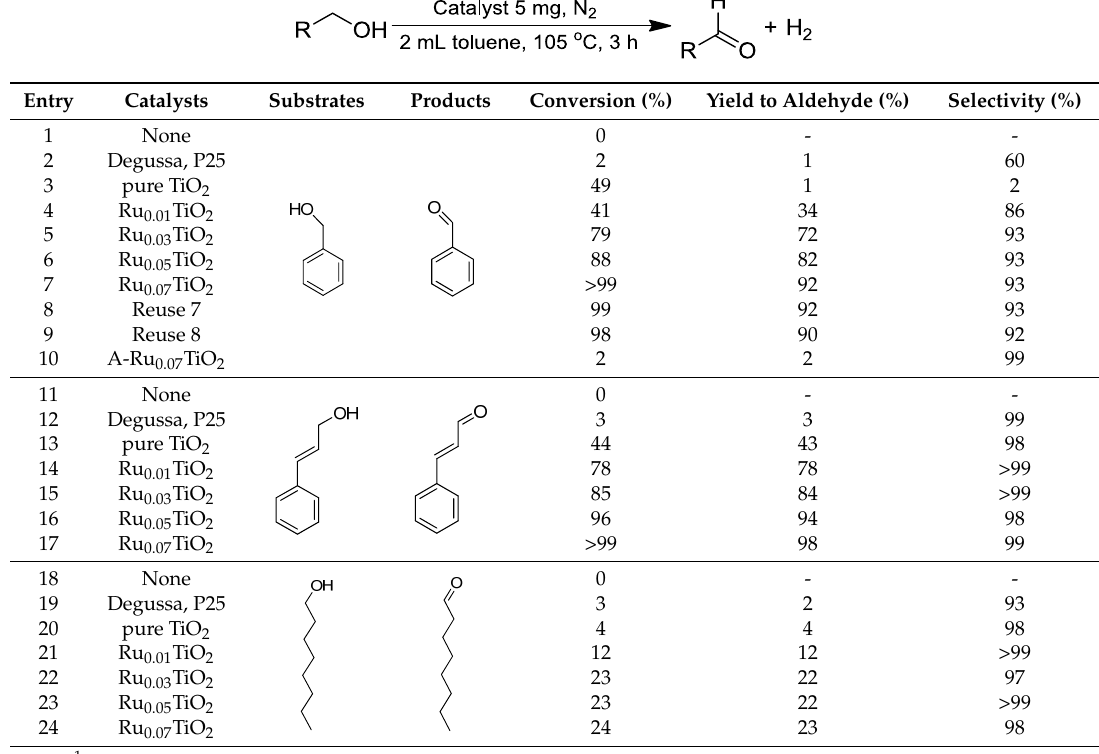
Table 2. Catalytic properties of alcohol oxidation under oxidant-free conditions 1 .